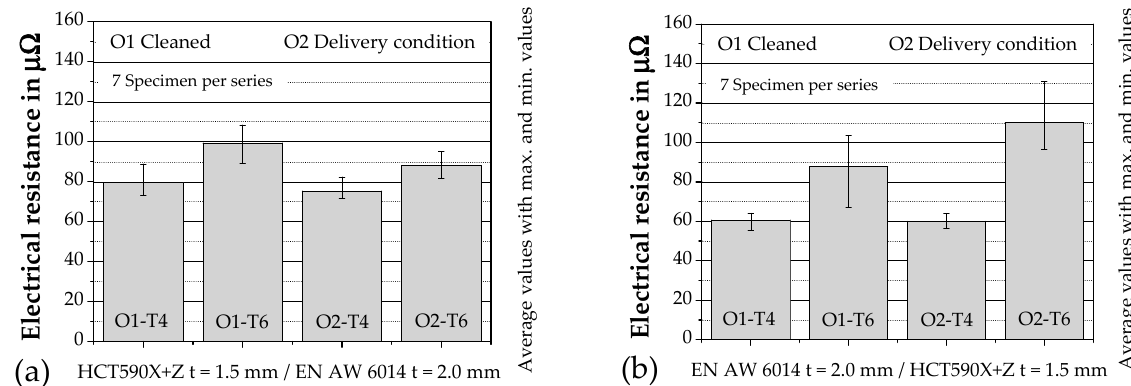
Figure 7. Electrical resistance by variation of joining direction and surface condition .